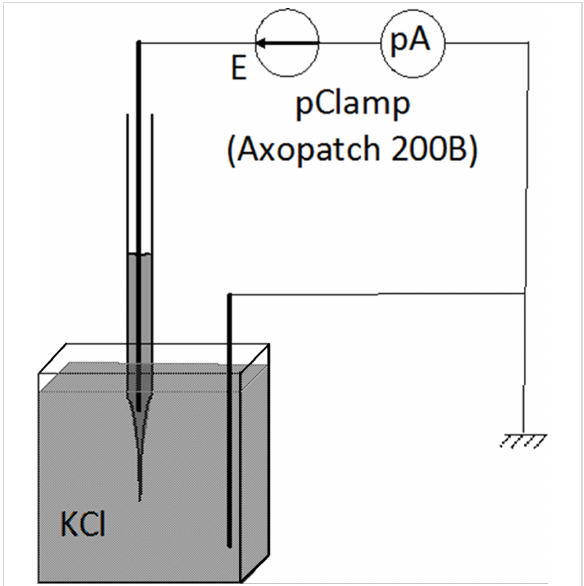
Figure 5: Electrical measurement: one Ag/AgCl electrode is intro- duced into the large part of the capillary loaded with KCl electrolyte and connected to the head-stage of the Axopatch 200B, the tip of the capillary is plunged into the KCl bath of same concentration, a second Ag/AgCl electrode is plunged into this bath and directly connected to ground. The entire electrical measurement setup is placed under a Faraday